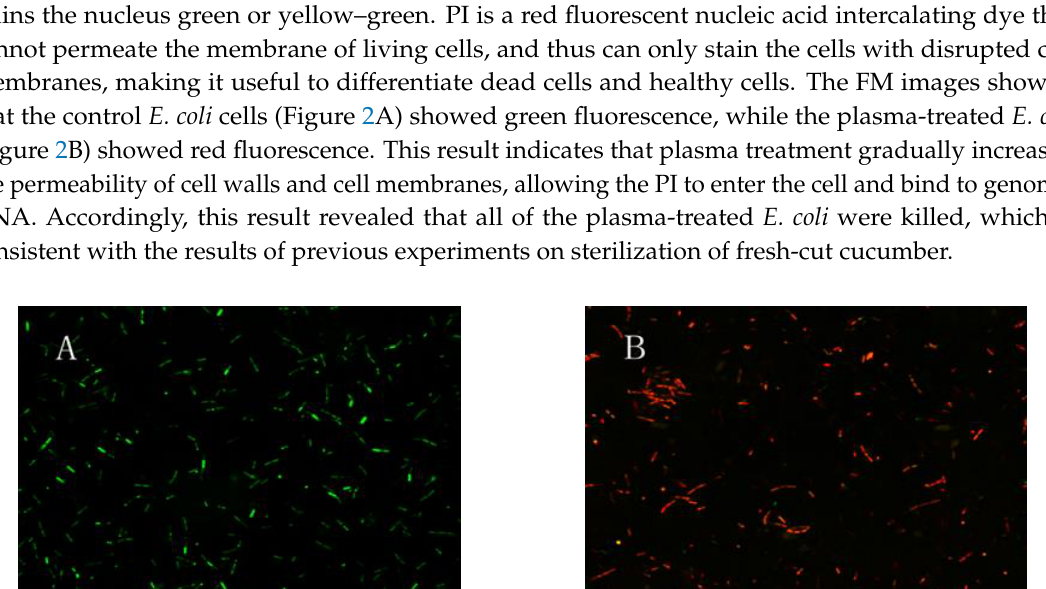
Figure 1. Scanning electron microscopy (SEM) images of E. coli. ( A ) Control E. coli ; ( B ) Treated E. coli.